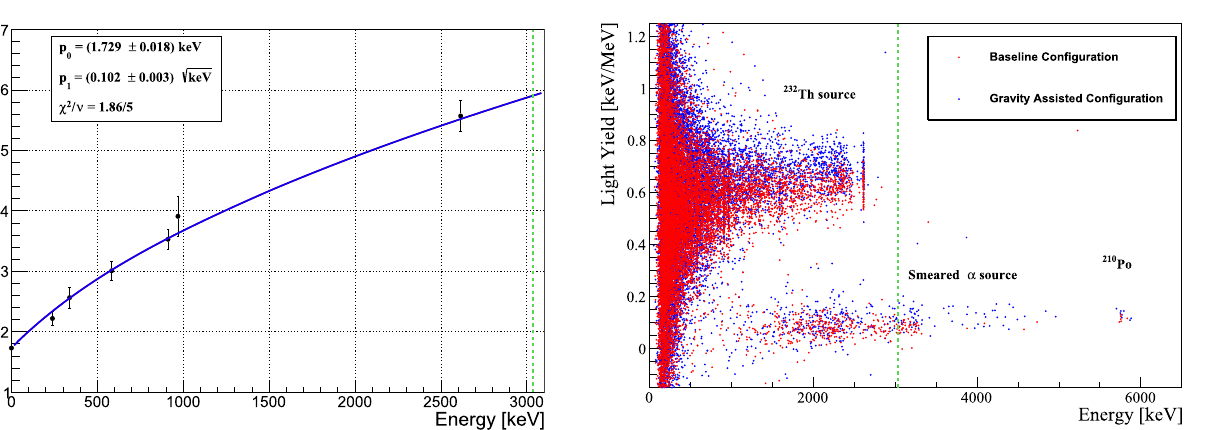
Fig. 4 FWHM of the most intense γ peaks as a function of the energy in the sum spectrum of the 8 LMO crystals. We find that the function which best describes the data is FWHM = with a blue line. The green dotted line represents the 100 Mo Q -value